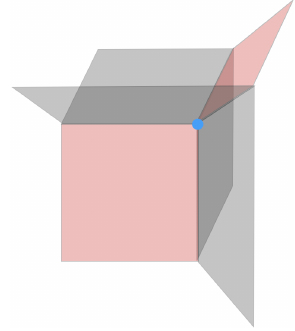
Figure 3 . A simple vertex configuration in a BFT 2 , where the vertex is highlighted in blue. It is shared by two Fermi faces and four edges.